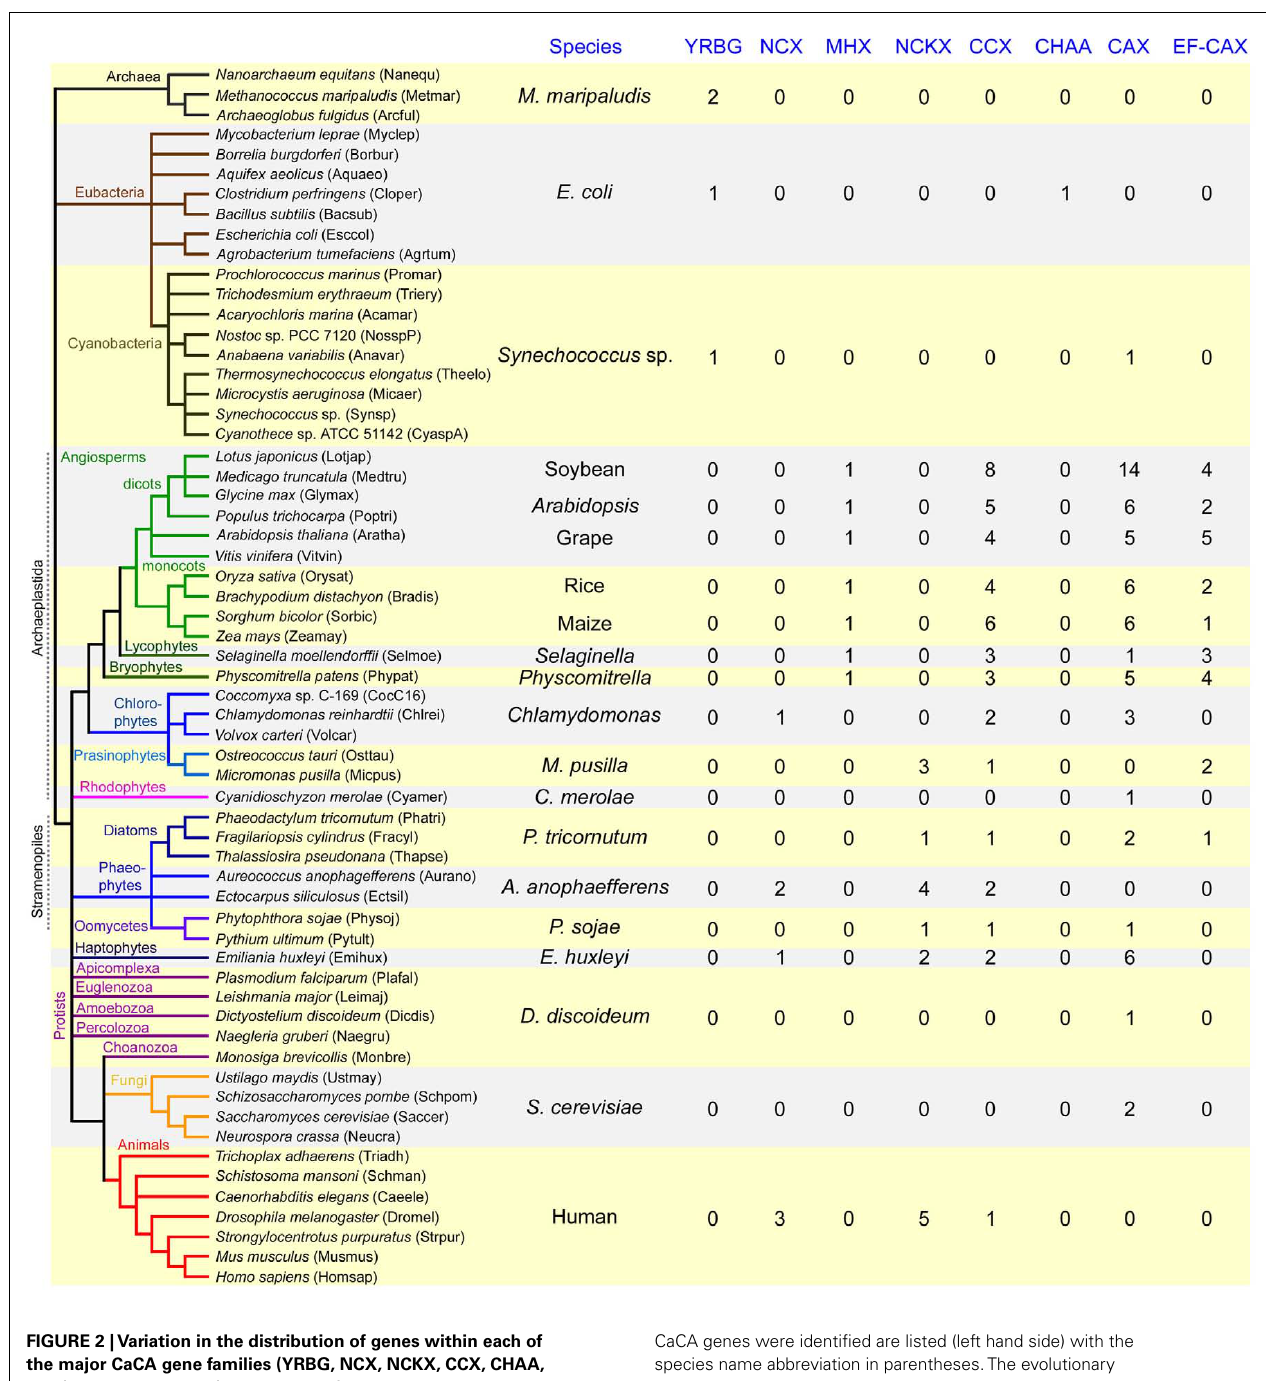
FIGURE 2 |Variation in the distribution of genes within each of the major CaCA gene families (YRBG, NCX, NCKX, CCX, CHAA, CAX) and sub-families (MHX, EF–CAX) across eukaryotic and prokaryotic organisms. Gene numbers determined by phylogenetic analysis from representative species for each of the classes of organisms examined are shown.The species from which